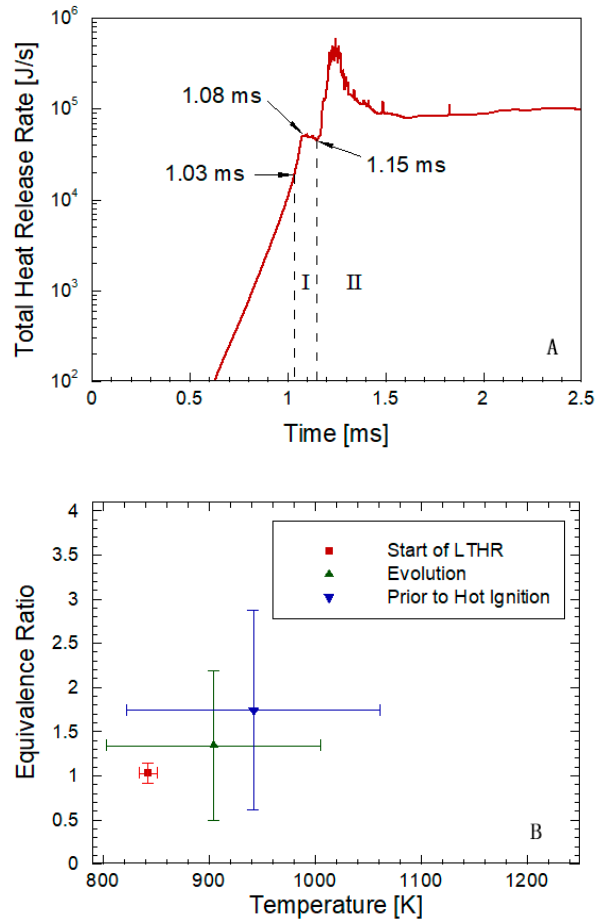
Figure 6. Schematic diagram of the evolution of the total HRR ( A ) and the exothermic region ( B ) at 850 K for an injection pressure of 100 MPa.